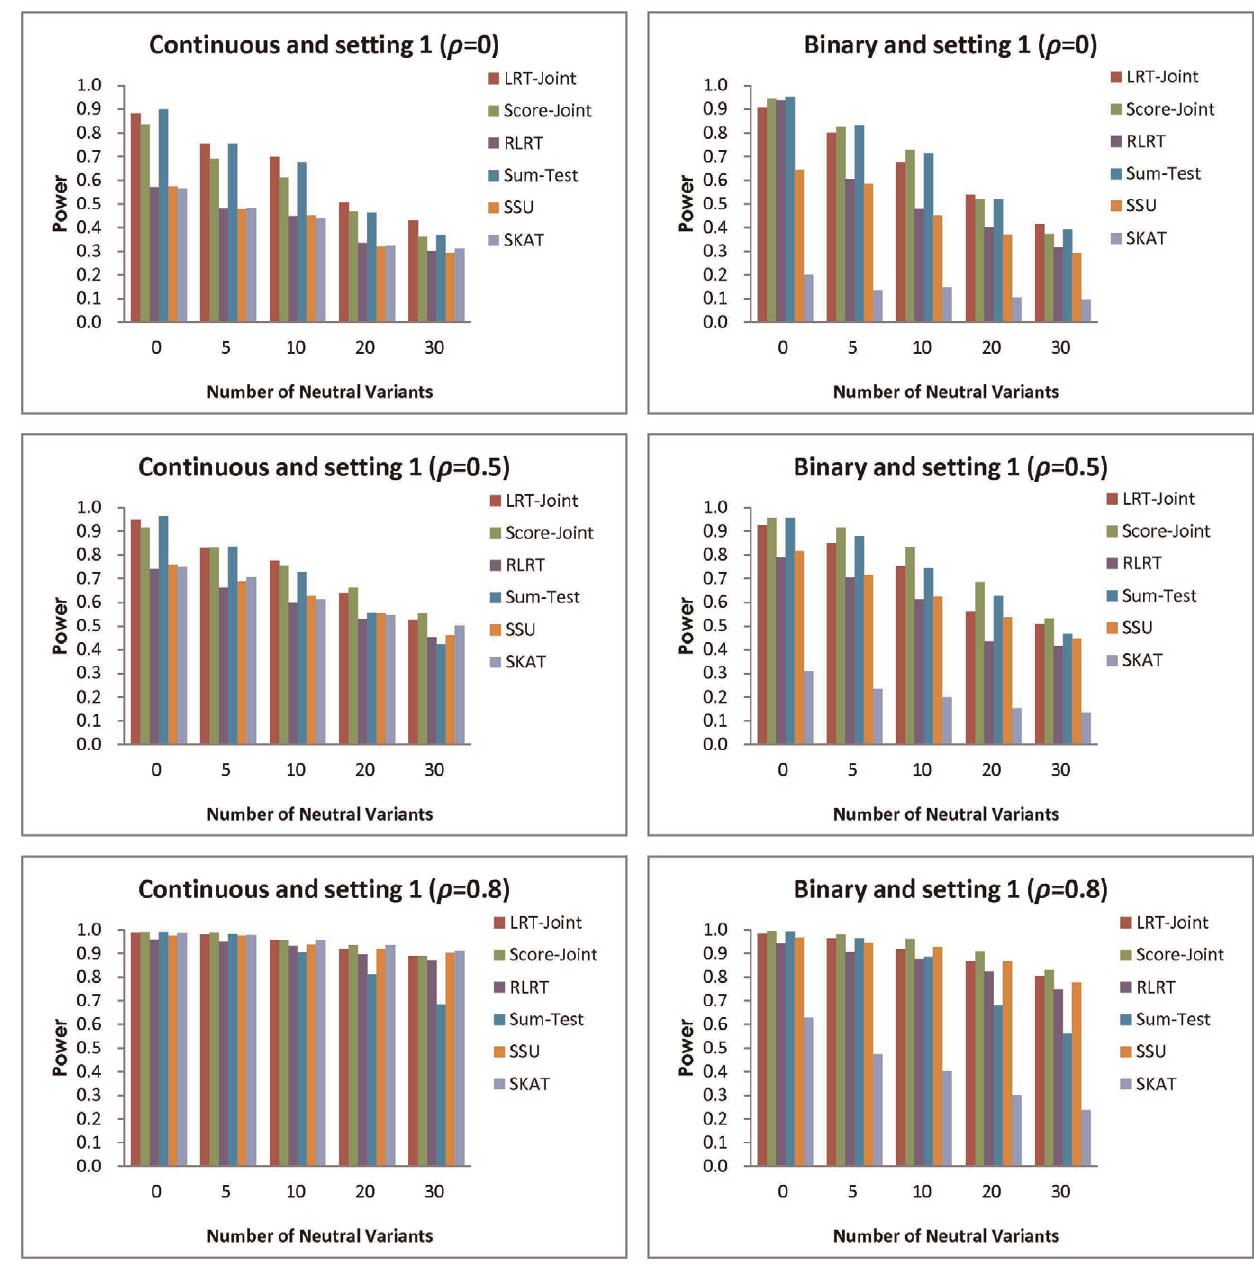
Figure 3. Simulation setting 1: b k ~ ( 0 : 3 , 0 : 3 , 0 : 3 , 0 : 3 , 0 : 3 , 0 : 3 , 0 : 3 , 0 : 3 , 0 : 3 , 0 : 3 ) T ( continuous trait ) , and OR ~ ( 2 , 2 , 2 , 2 , 2 , 2 , 2 , 2 , 2 , 2 ) T ( binary trait ) .